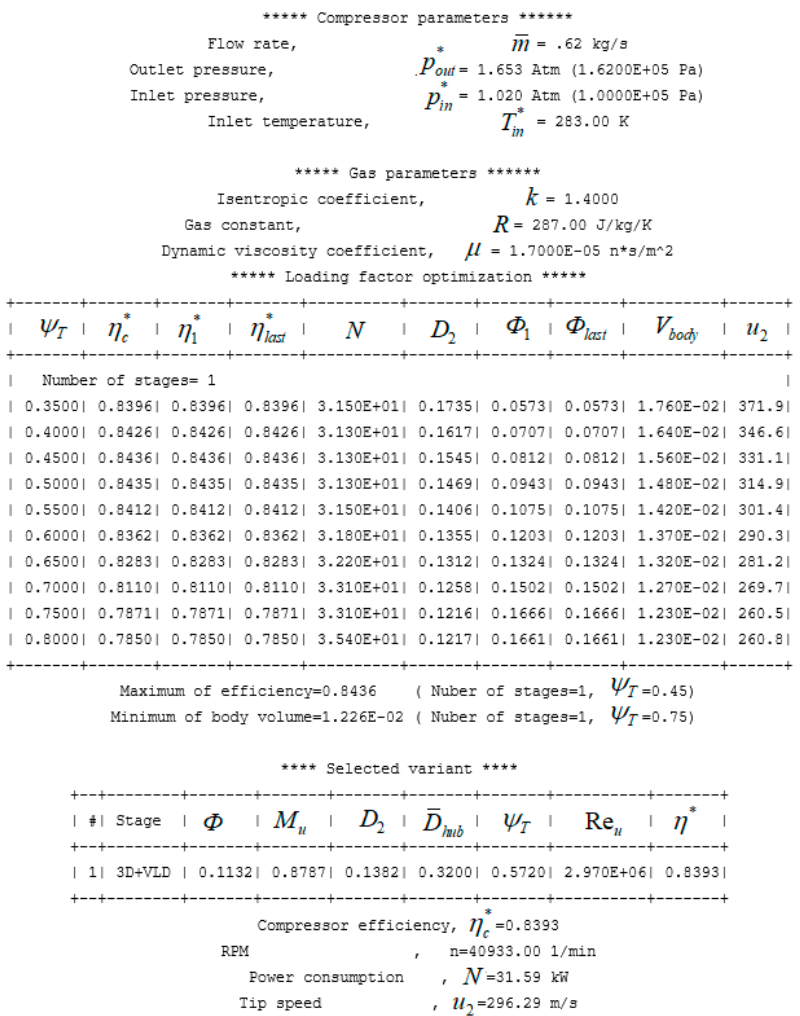
Figure 1. PDCC-G8E program. Variant calculation of TKR 140E. Efficiency and flow coefficient versus the design loading factor.